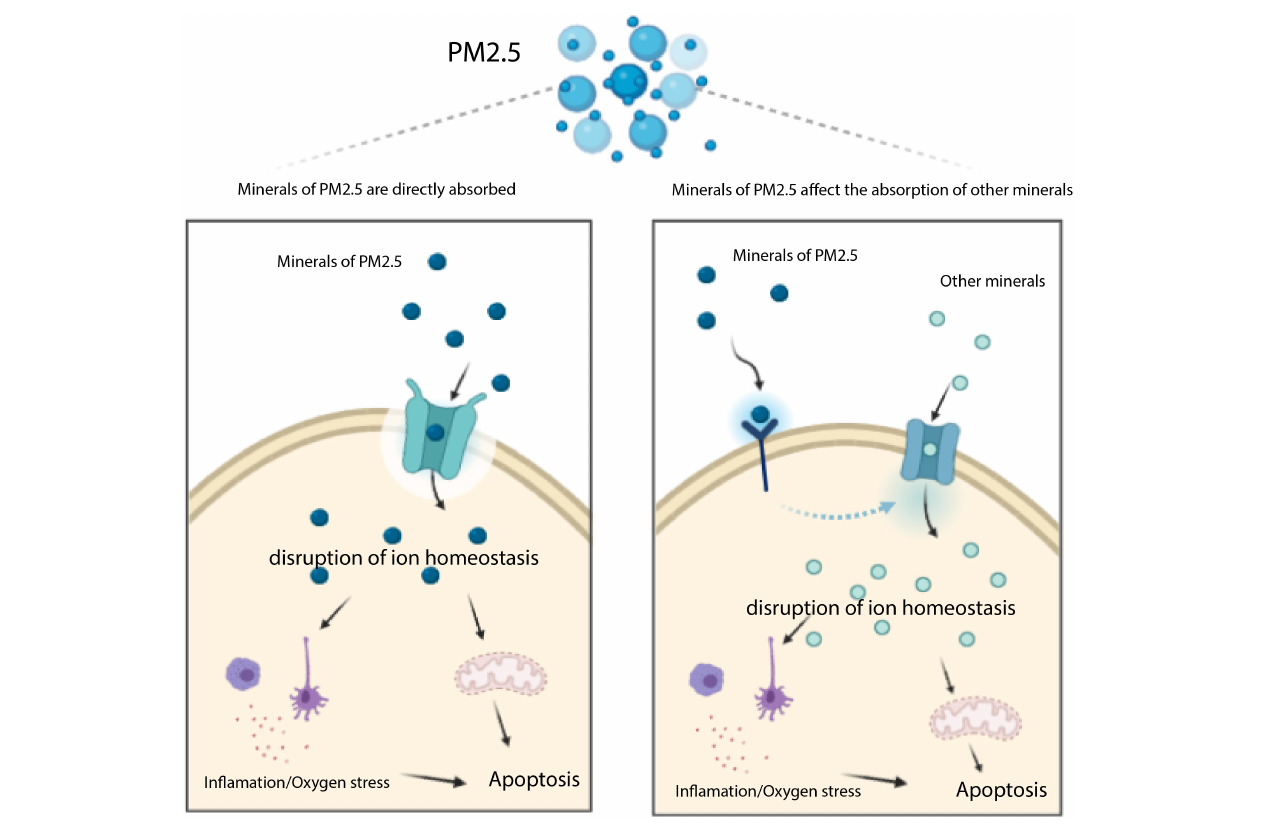
FIGURE 6 | Transportation of toxic chemicals (metals and minerals) in PM2.5 induces apoptosis mediated by ROS. The minerals of PM2.5 may be trasported into cell through transporters (e.g. MT1M, ATP1A2, SLC6A19, and TRPV6 encoding proteins), they may also affect other transporters which uptake other minerals inducing